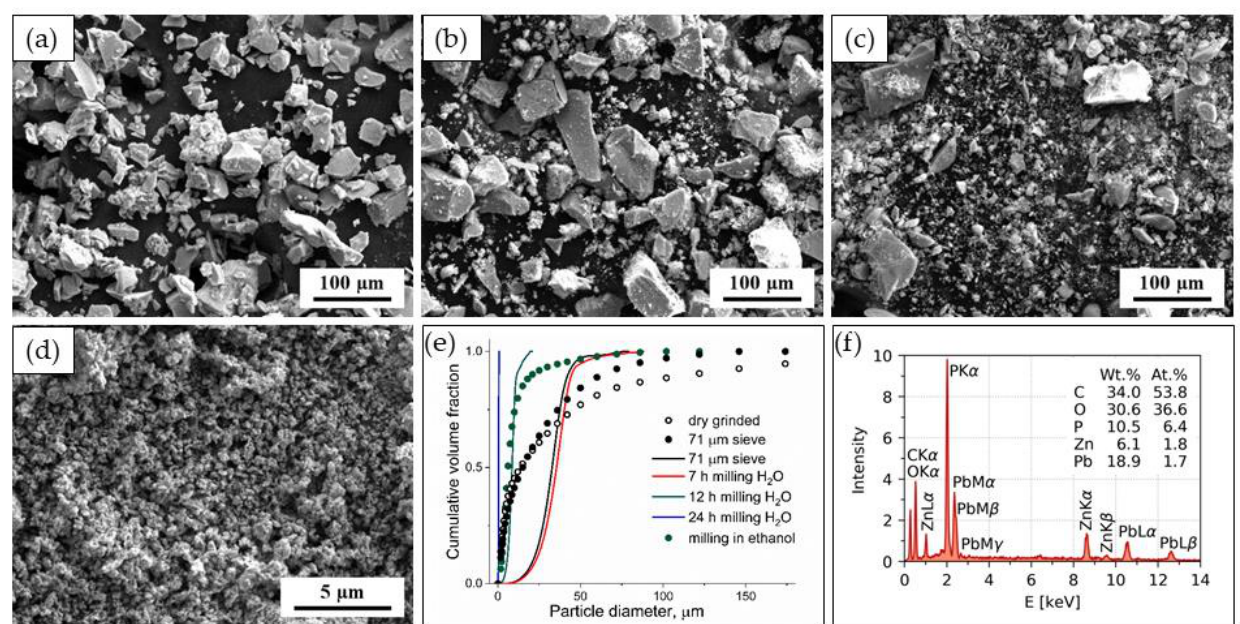
Figure 3. SEM micrographs of initial PbO·ZnO·P 2 O 5 coarse powder ( a ), after milling in water for 7 h ( b ) 12 h ( c ) and 24 h ( d ); volume weighted cumulative size distributions for glass powders ( e ) (lines — obtained from SEM micrographs, scatter — obtained from laser diffraction) and typical EDX for coarse powder ( f ). Table 1. Parameters for the volume-weighted cumulative PSDs of PbO · ZnO · P 2 O 5 glass powders prepared after different stages of